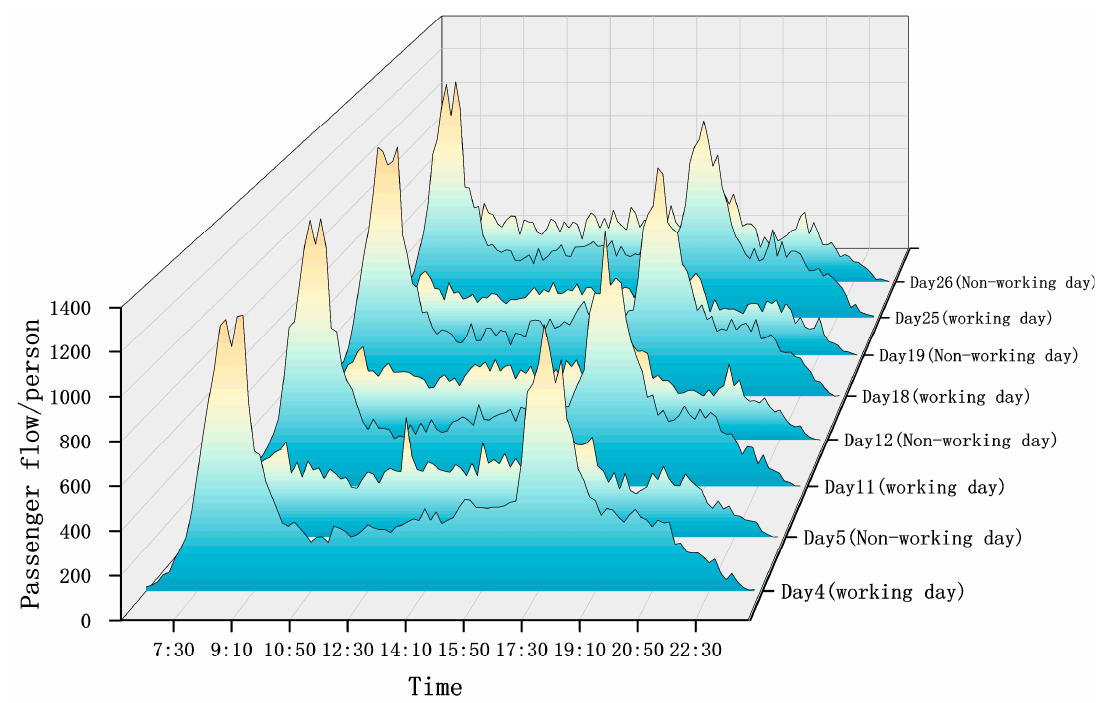
Figure 2. Passenger flow of Hangzhou Metro Jinjiang station on weekdays and weekends.